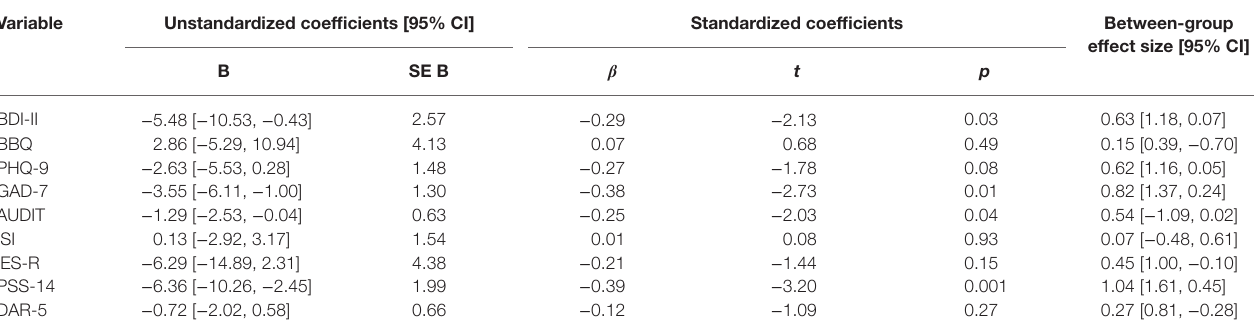
TABLE 3 | Regression model of the impact of group condition on primary and secondary outcome measures with variance explained by pre-treatment measure included.